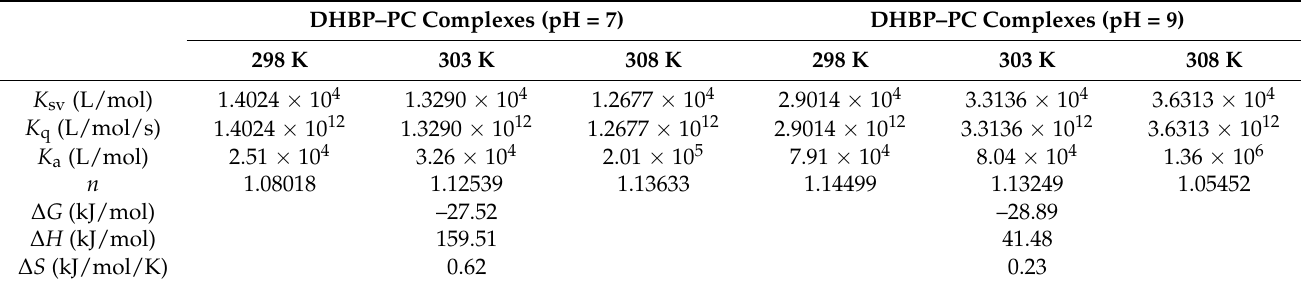
Table 2. Fluorescence quenching parameters of decolorized highland barley protein (DHBP)– proanthocyanidin (PC)